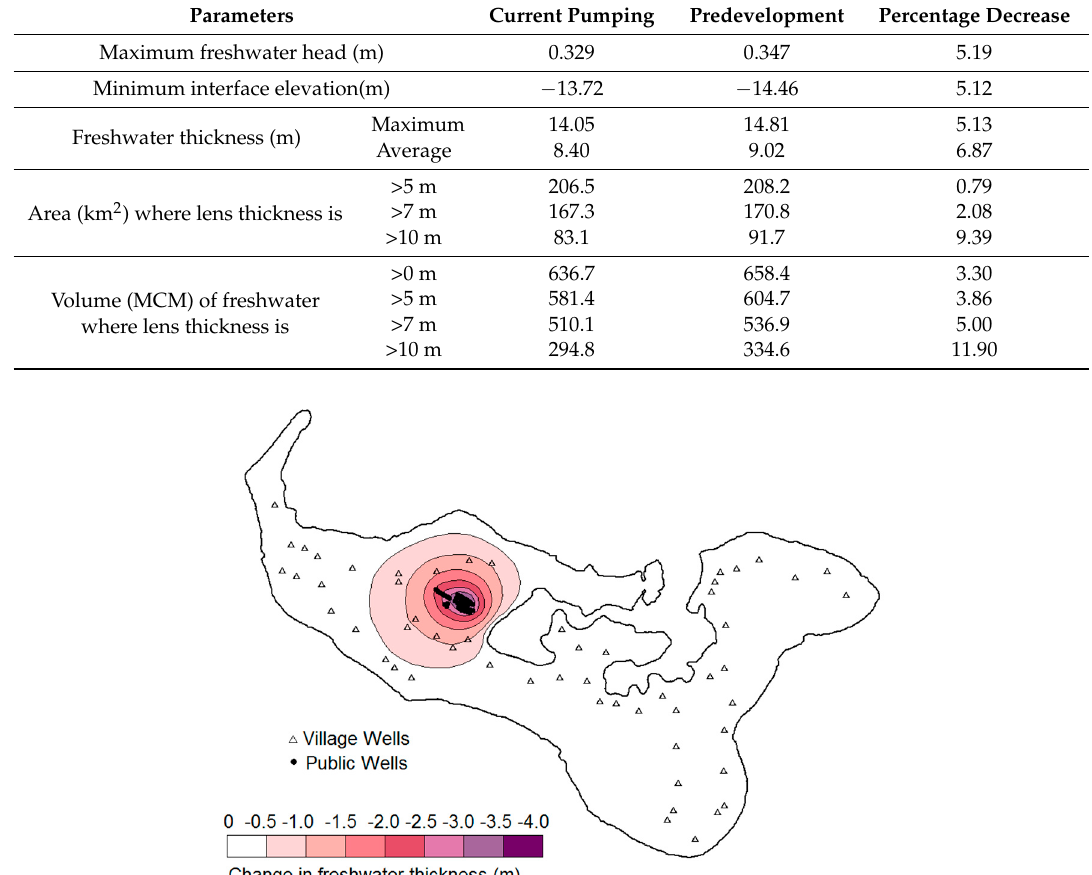
Table 3. Impacts of the current pumping condition.